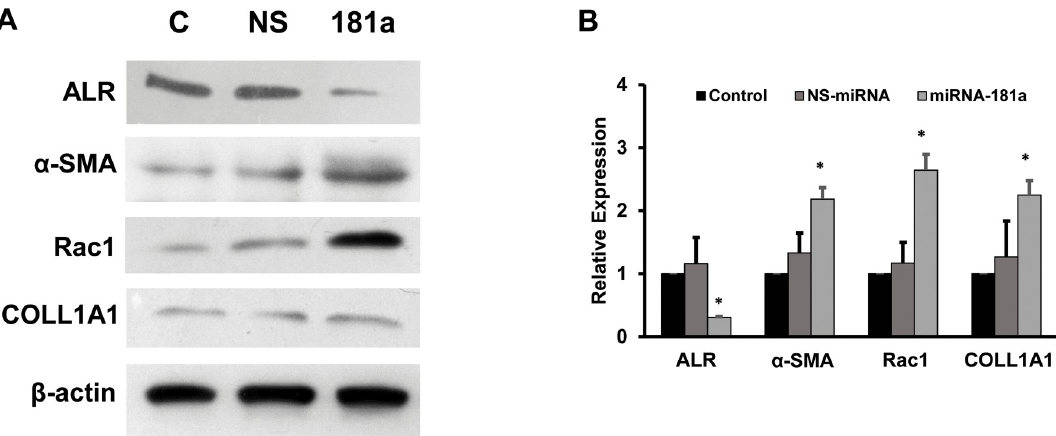
Fig 3. Role of miRNA-181a on the expression of ALR and fibrogenic markers. A. LX2 cells were transfected with miRNA-181a mimics as described in materials and methods. The expression of ALR, α -SMA, rac1, COLL1A1 and β -actin were determined using Western blots. A representative picture from 3 experiments is shown. B. The bands from the Western blot experiments were quantitated using Image J software and the data are presented as relative expression (p < 0.05, compared to